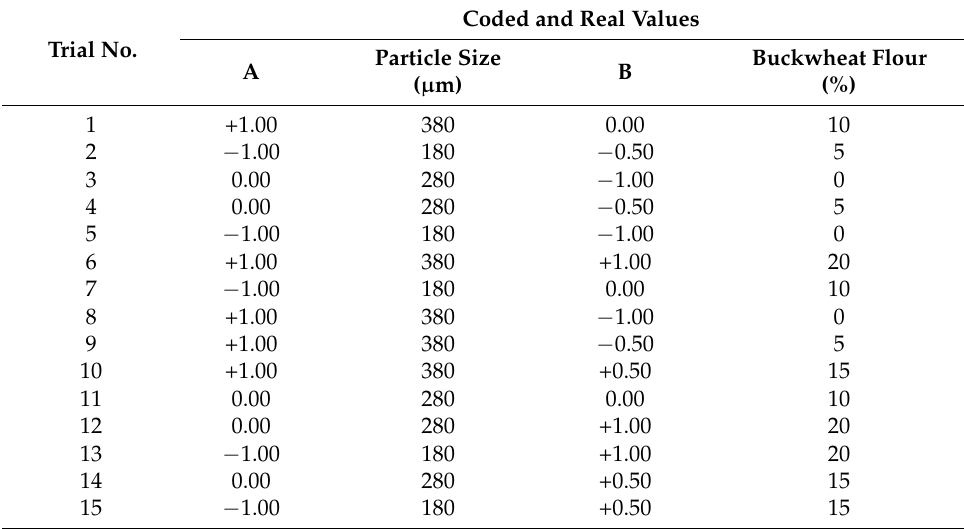
Table 1. Factors and their level in experimental design.